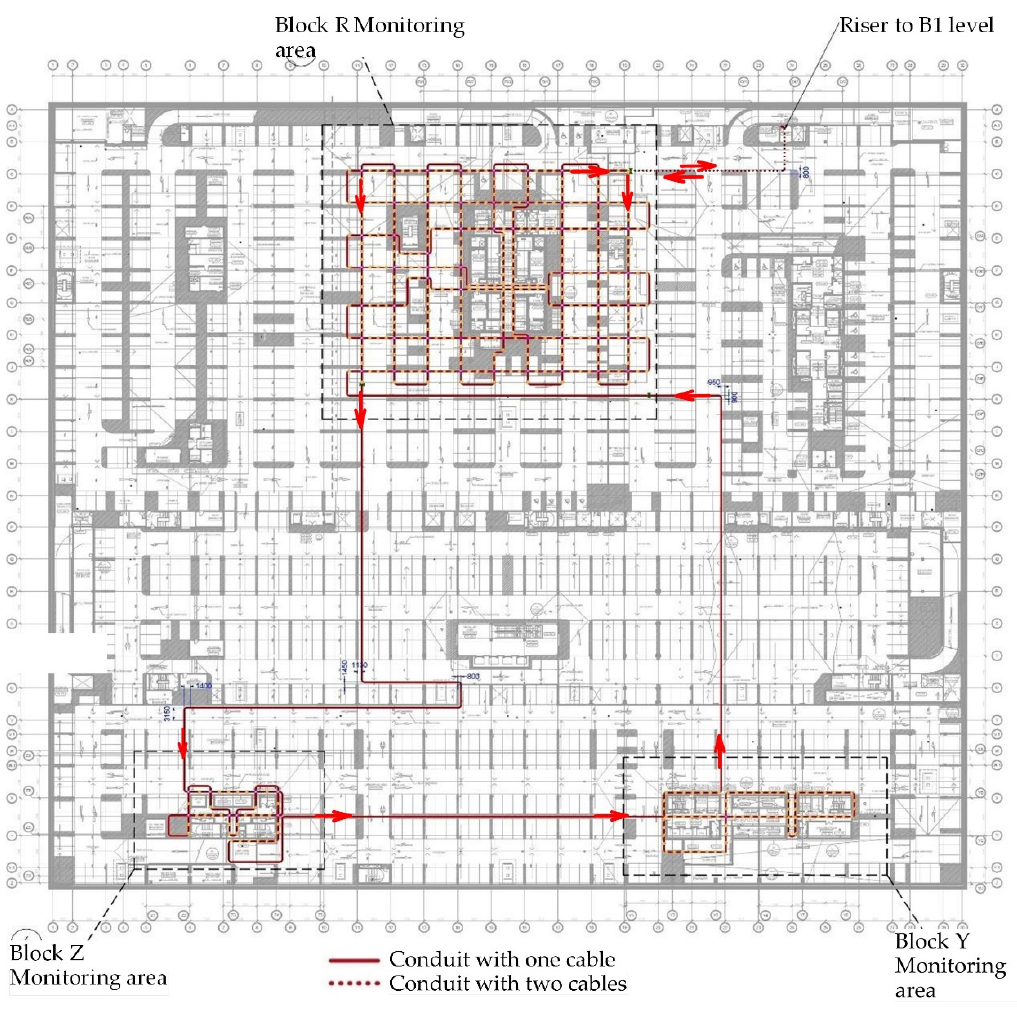
Figure 5. Part plan of cable routing in Block R monitoring area on B4 raft.